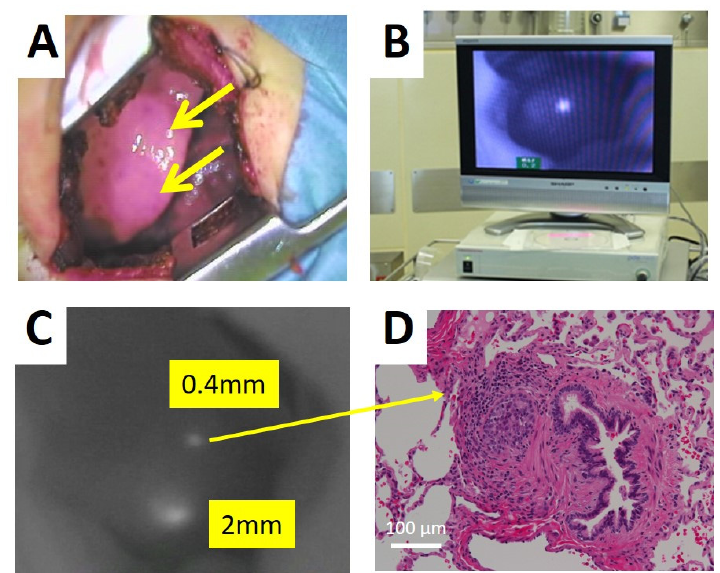
Figure 2. PDE system for the detection of lung metastases by ICG fluorescence (Hamamatsu Pho- tonics: PDE System ® ). ( A ) Surgical field under thoracotomy. The metastatic nodules were invisible. ( B ) Video screen of ICG navigation surgery. ( C ) ICG positive nodules. ( D ) The pathological finding of a small ICG positive nodule. Table 1. Reported ICG navigation surgery in hepatoblastoma.